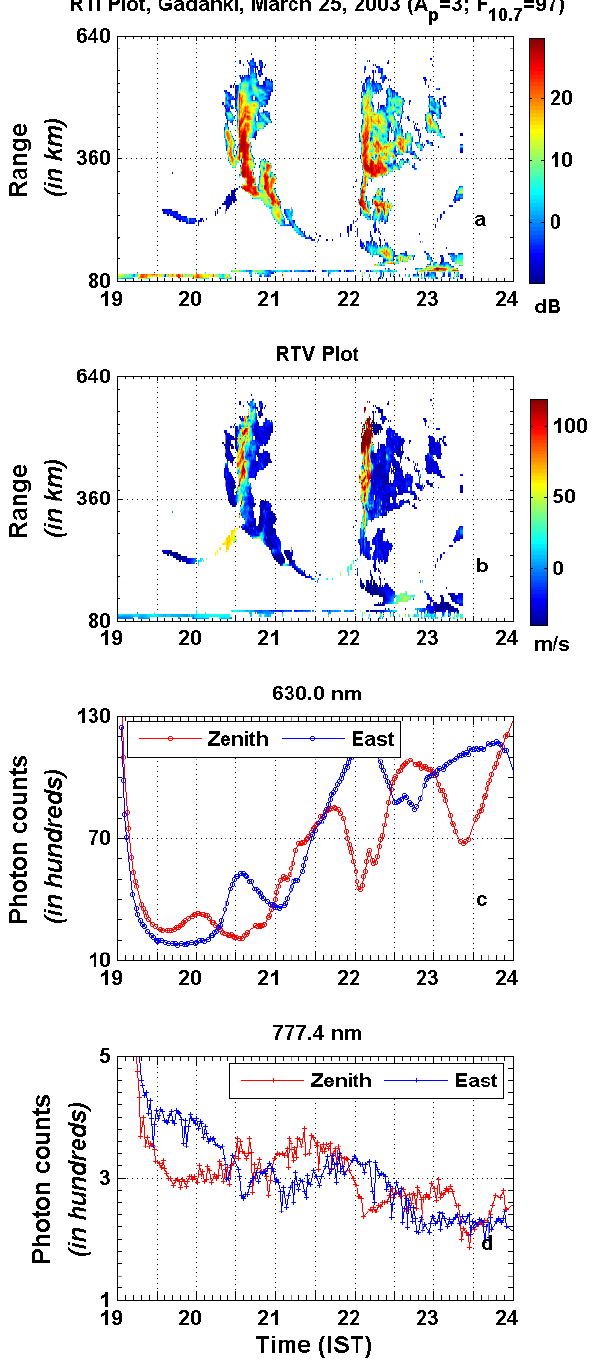
Fig. 3. Similar to Fig. 2 but for 25 March 2003 revealing wave- like bottomside structure with large altitude extents. Note that the integration time for airglow observations is